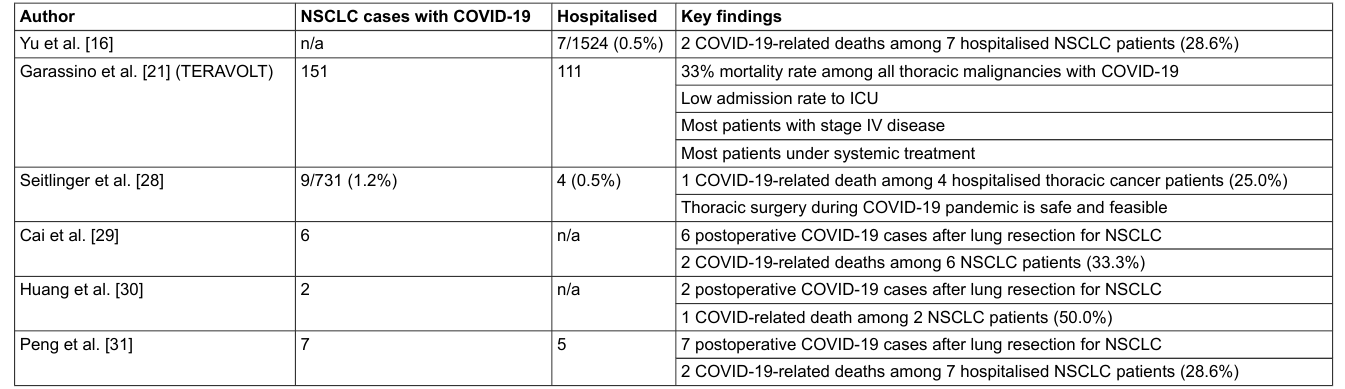
Table 1: Lung cancer patients at